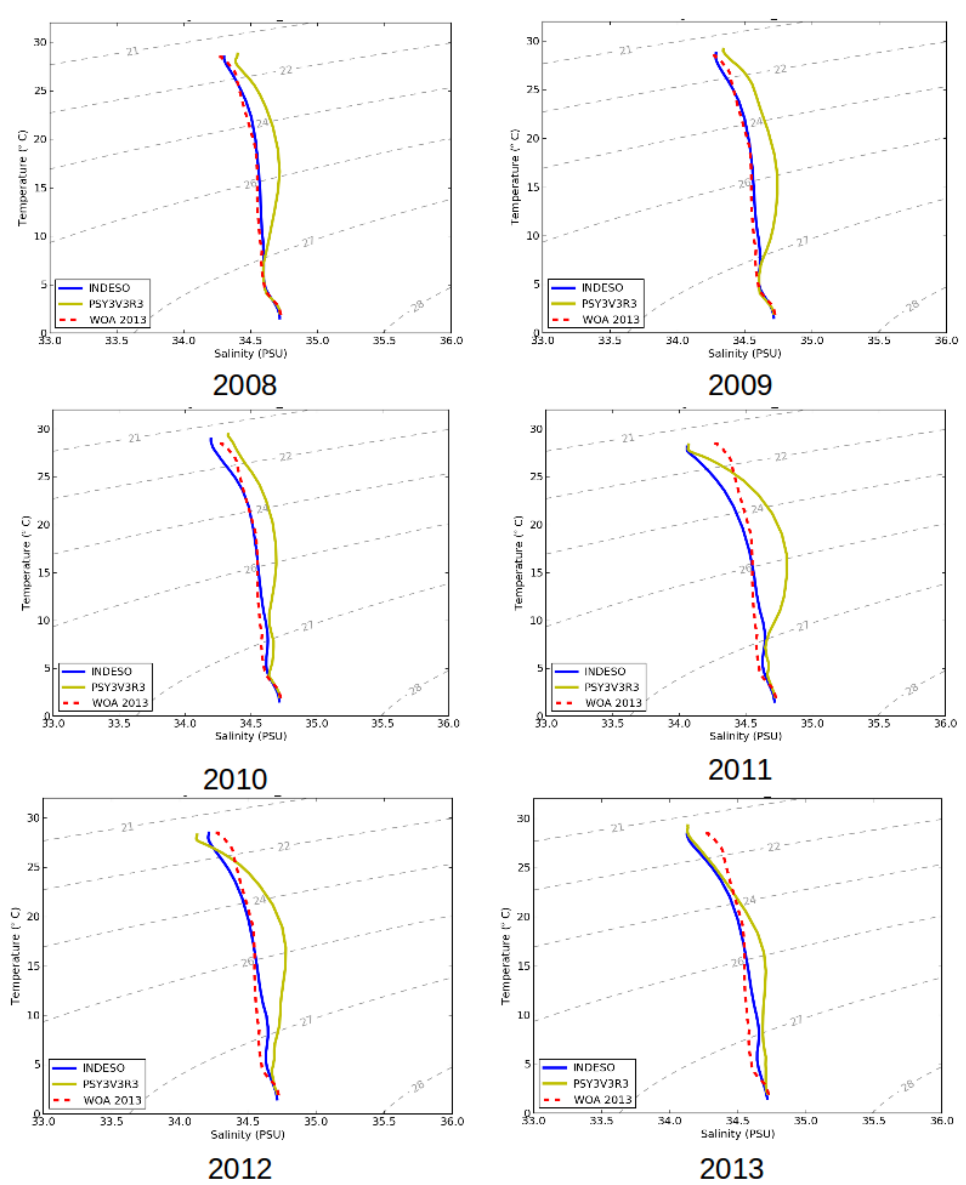
Figure 18. T – S diagrams from INDO12 simulation (blue line) averaged on the Timor region and compared to climatologies WOA 2013 (red dotted line) and PSY3V3R3 (yellow line) for years 2008 to 2013. Salinity (PSU) and temperature ( ◦ C) are plotted along x and y axes,